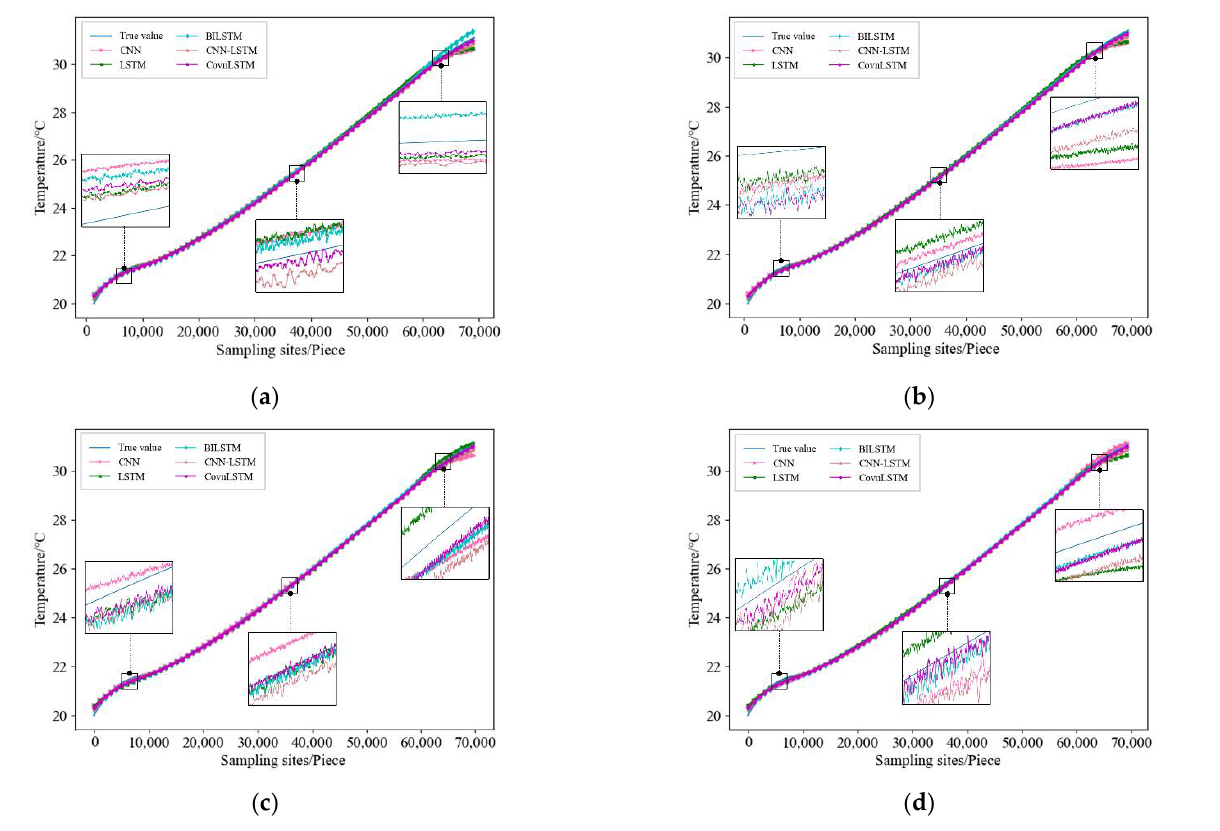
Figure 8. Diagram of cross-validated prediction results for simulation model. ( a ) Prediction re- sult of training set 1. ( b ) Prediction result of training set 2. ( c ) Prediction result of training set 3. ( d ) Prediction result of training set